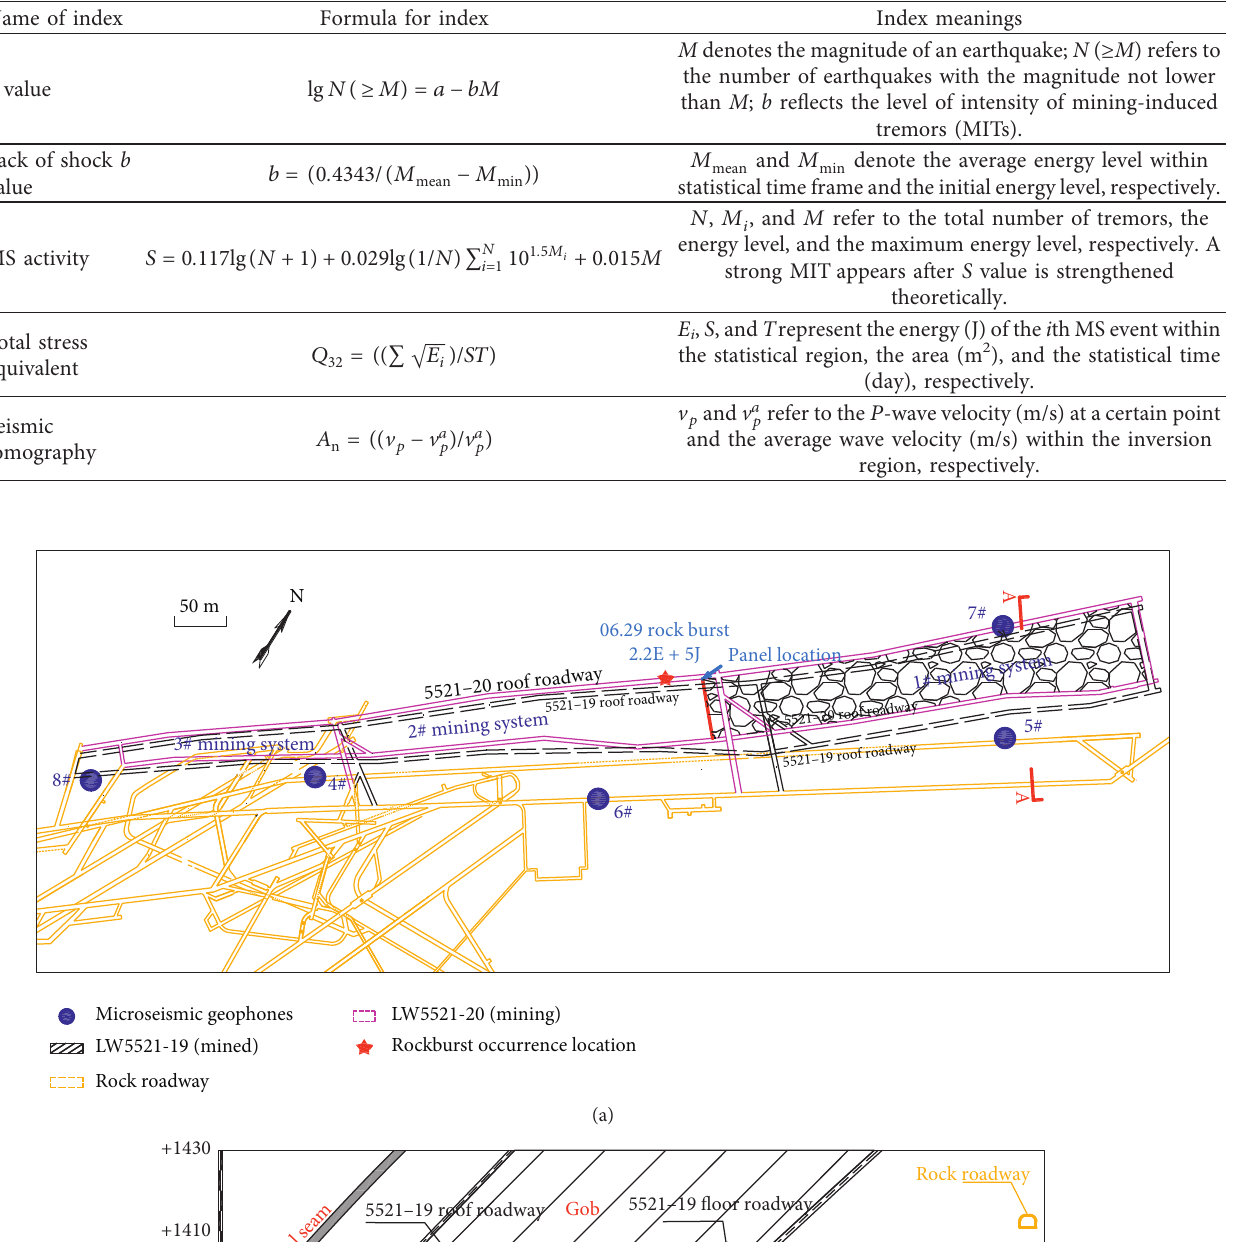
Table 1: Monitoring and warning indices and meanings.